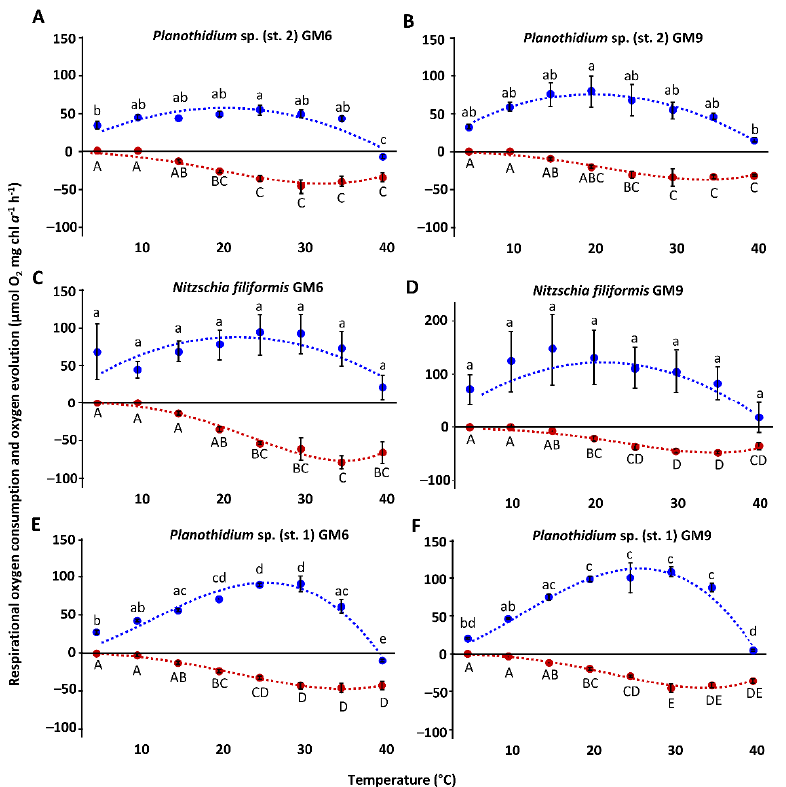
Figure 6. Photosynthetic (blue) oxygen production at 303.4 ± 11 µmol photons m –2 s –1 and respiratory (red) oxygen consumption in darkness of three peatland benthic diatom strains as a function of increasing temperature. The measured data were fitted by the model of Yan and Hunt [37] (photo- synthesis: blue dashed line; respiration: red dashed line). Cultures were kept in GM6 media ( A , C , E ) and GM9 media ( B , D , F ). Data represent mean values ± standard deviation (n = 3). Different lower- case (photosynthesis) and capital letters (respiration) indicate significant means ( p < 0.05, one-way ANOVA with post hoc Tukey’s test). ( A ) Planothidium sp. (st. 2) GM6, ( B ) Planothidium sp. (st. 2) GM9, ( C ) Nitzschia filiformis GM6, ( D ) Nitzschia filiformis GM9, ( E ) Planothidium sp. (st. 1) GM6, and